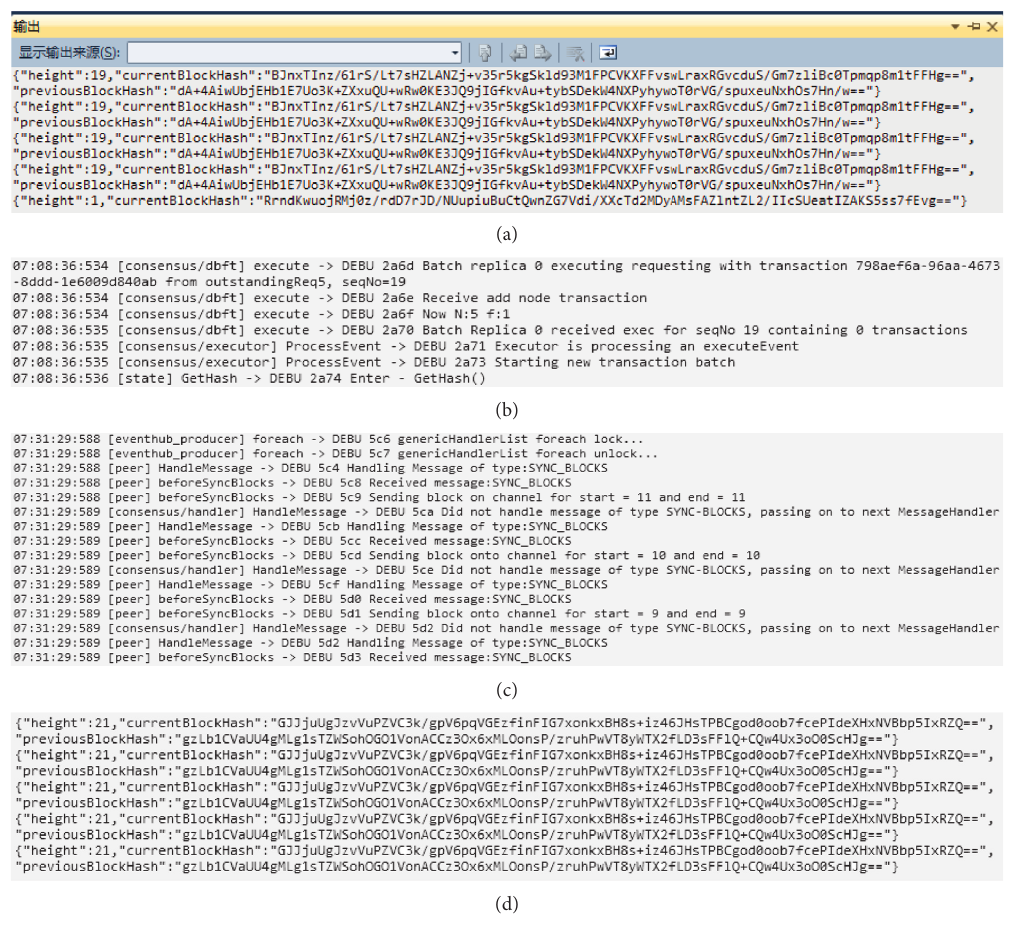
Figure 8: Process of dynamic node addition: (a) state before the now node joins the blockchain; (b) updating of node configuration; (c) block synchronization; (d) block synchronization